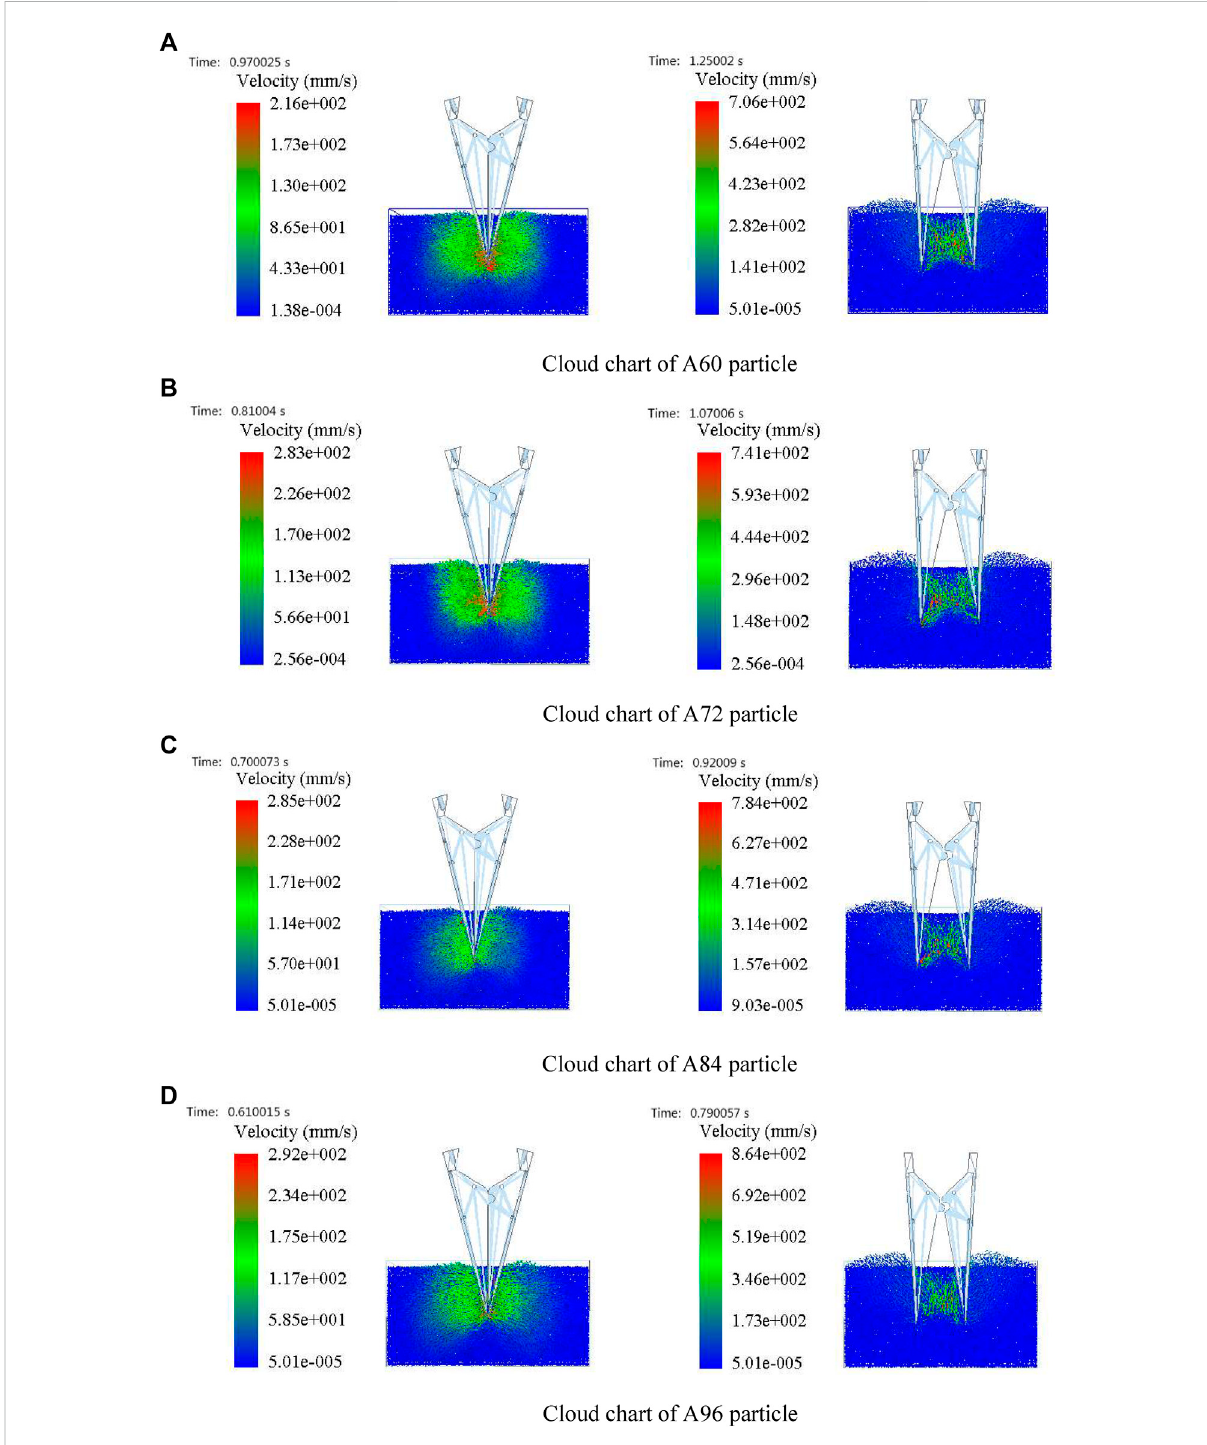
FIGURE 7 Cloud chart of particle change during the movement of a triangular conic hanging